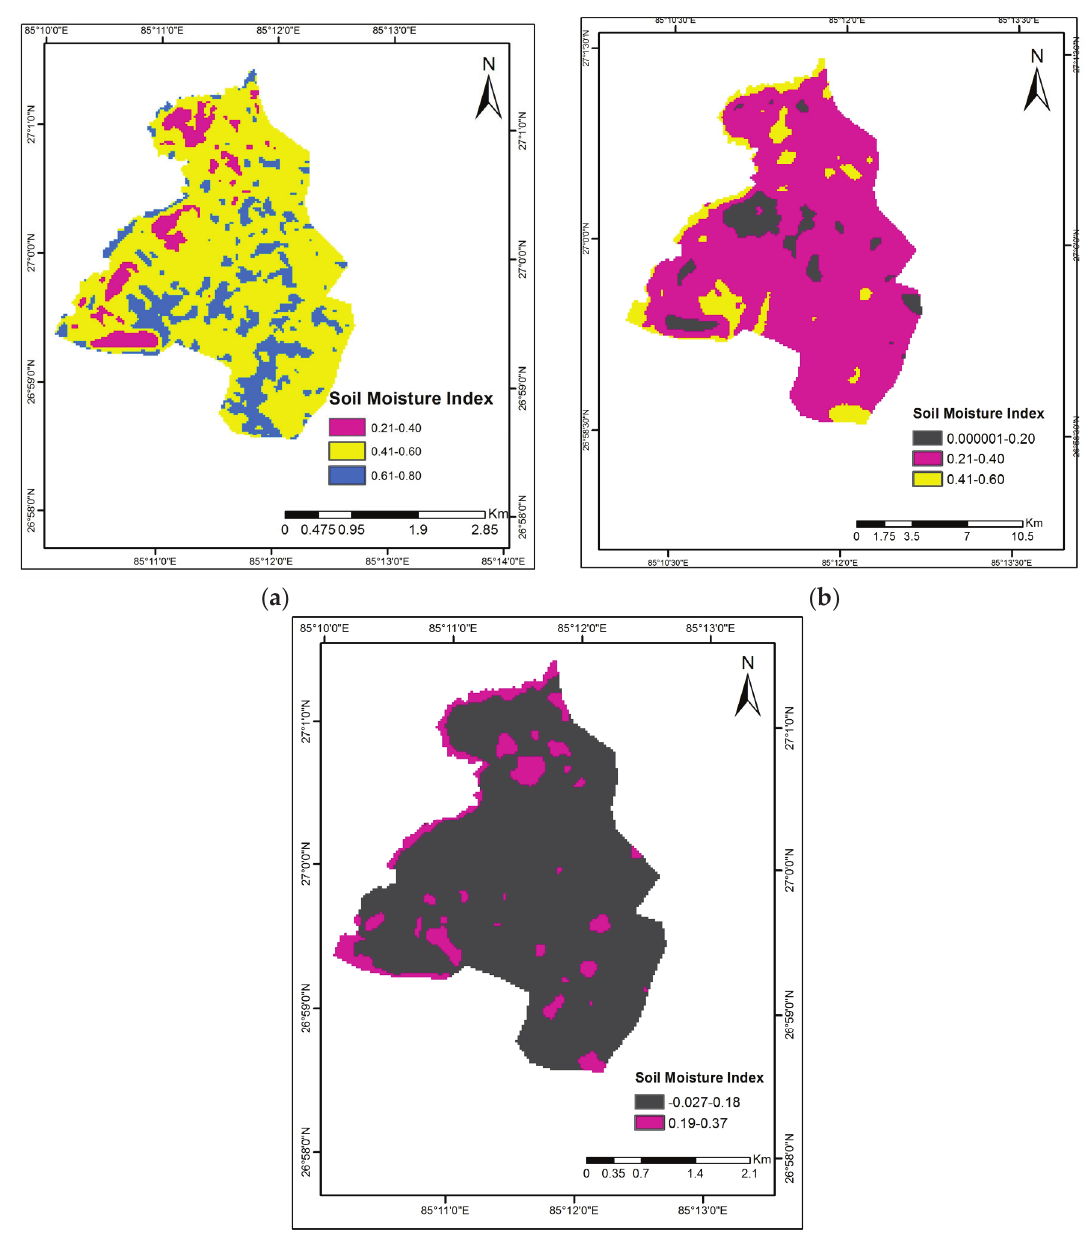
Figure 7. Soil moisture index of Santapur VDC for different years: ( a ) 2000; ( b ) 2014; and ( c ) 2015. Table 8. Soil moisture index (SMI) for the different years in Santapur VDC.